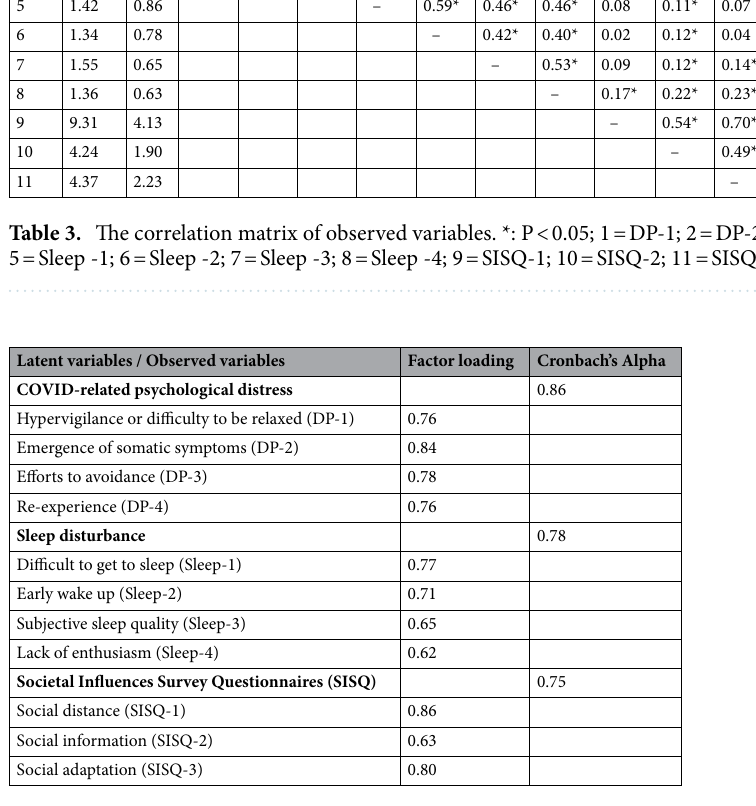
Table 4. Principle component analysis for factors in the conceptual model.